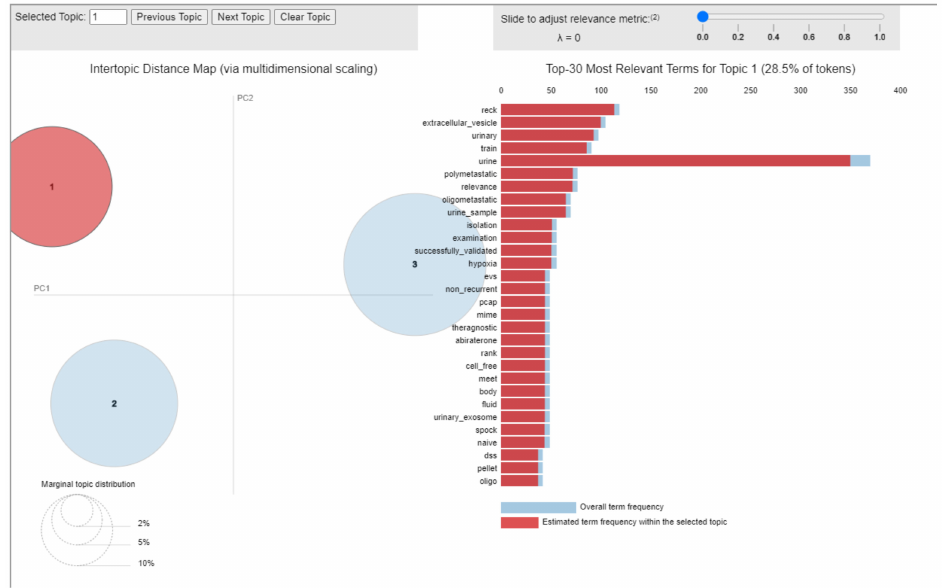
Figure 7. Inter-topic Distance Map related to topic 1. Circle 1 indicates topic 1, circle 2 is topic 2 and circle 3 is topic